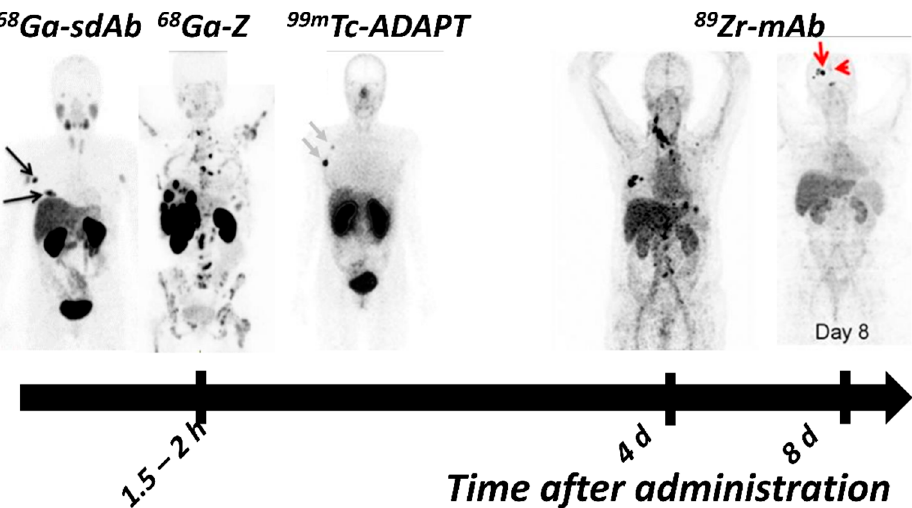
Figure 3. Imaging of HER2 expression in patients using 68 Ga-sdAb [71][90] and affibody ([ 68 Ga]Ga- ABY-025 [78], abbreviated 68 Ga-Z) and ABD Derived Affinity Proteins (ADAPT) labeled with 99m Tc [169], and 89 Zr-labeled mAbs trastuzumab (left [57]) and pertuzumab (right [182][191]. These im- ages were originally published in JNM [57,169,182,204] © SNMMI, Theranostics [78].